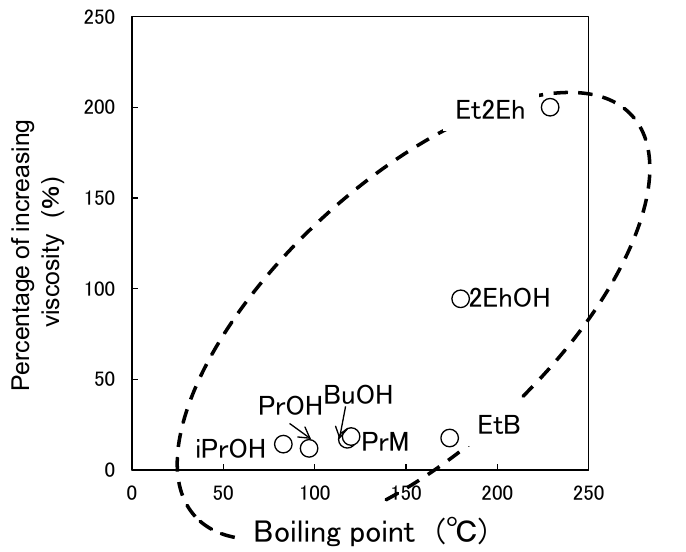
Figure 12. Relationship boiling point of the additional solvent and increasing viscosity percentage levels. Next, the relationship between k70/k100 values and the percentage of increasing viscosity is shown and the characteristic values of organic solvents that have the ability for both switchability and storage stability are